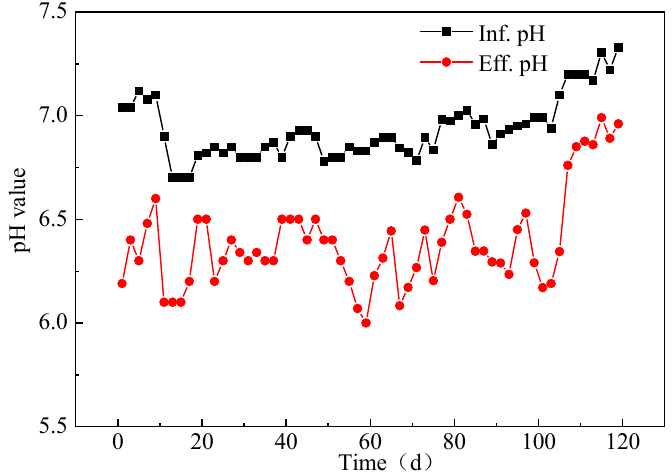
Figure 11. pH variation of pilot-scale bioreactor.